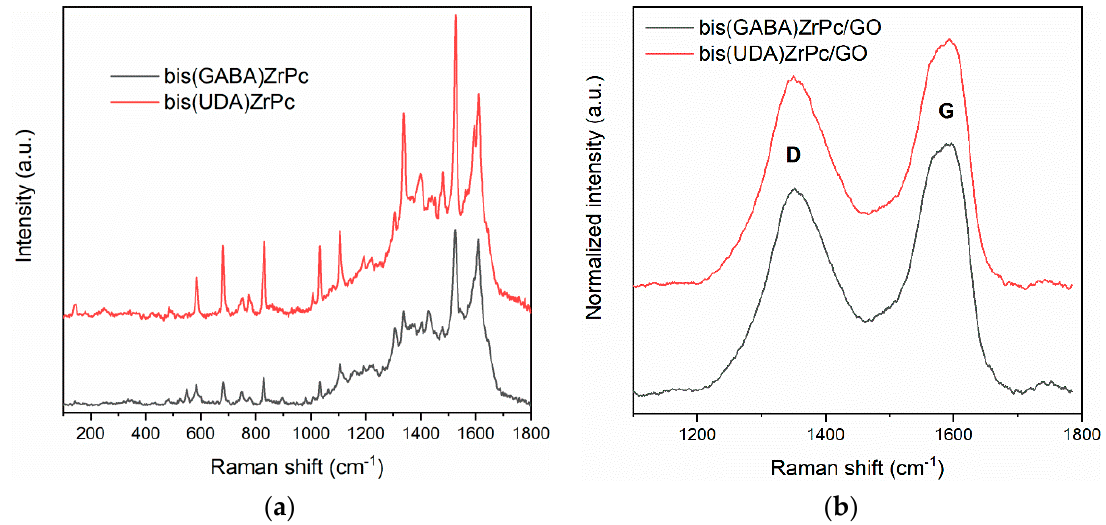
Figure 3. Raman spectra of investigated ( a ) ZrPcs and ( b ) ZrPc / GO samples ( λ = 488 nm). The photoluminescence excitation spectra of bis(4-aminobutyrato)ZrPc and this complex after embedding on graphite oxide are shown in Figure 4a (monitoring emission at 700 nm). Similar spectra were recorded for the second complex and composite. The photoluminescence spectra of all investigated samples—two ZrPcs and their composites with GO—in the red–NIR range are shown in Figure 4b (excitation wavelength 620 nm), where the intensity has been normalized for better